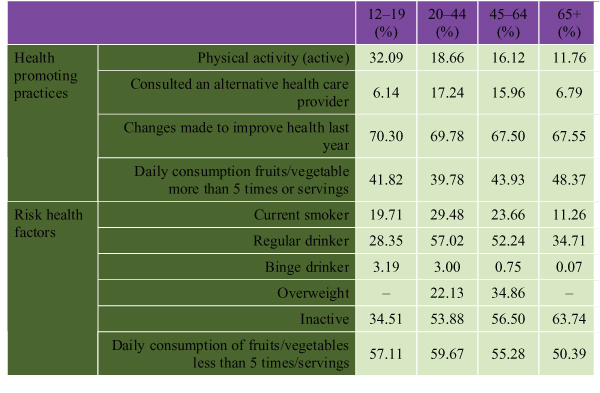
Age and Health Practices (not age-adjusted) Source: Statistics Canada, CCHS, 2000–2001